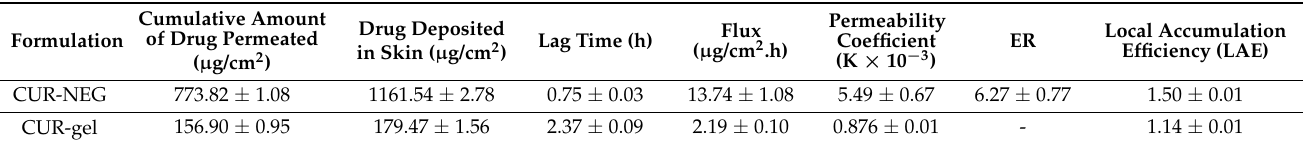
Table 3. Characterization of curcumin-loaded nanoemulgel to determine skin penetrability profile compared to conventional curcumin gel. “ER—enhancement